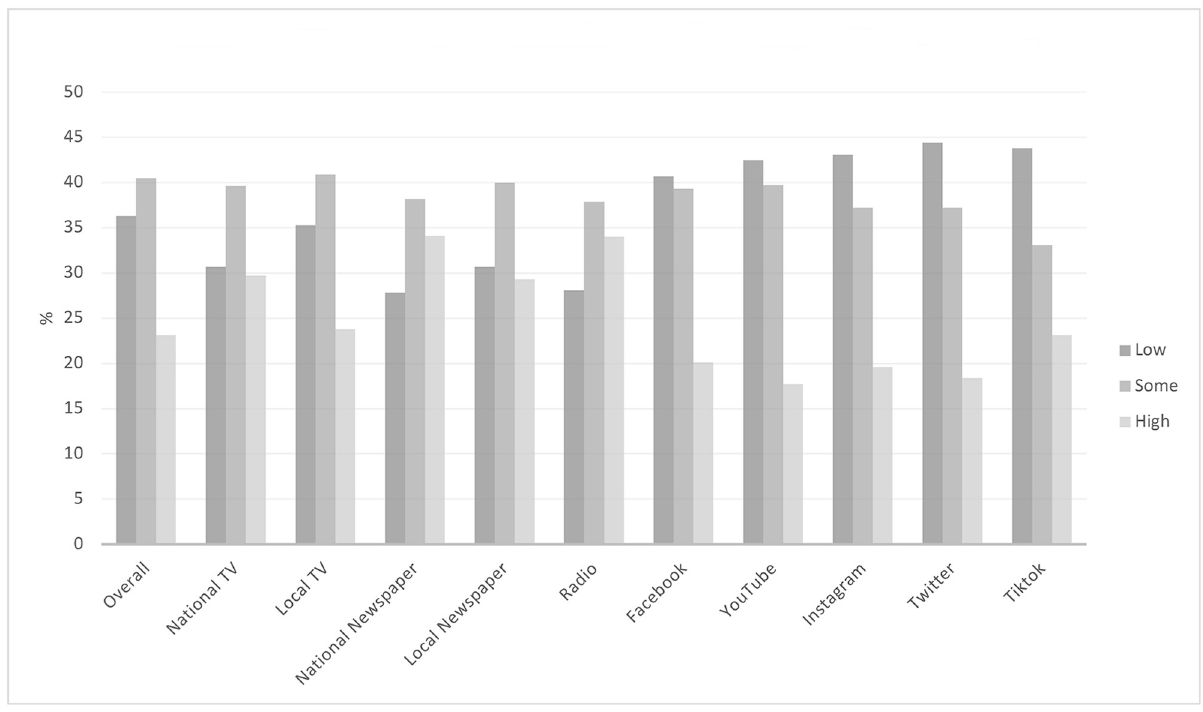
Fig 1. Trust in COVID-19 information by information